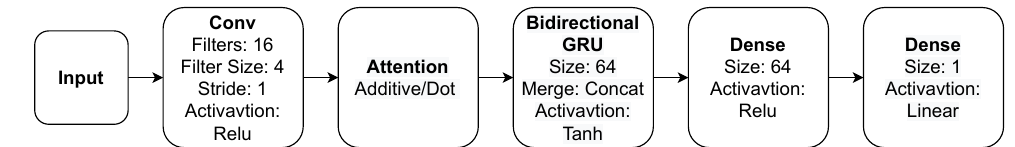
Figure 4. Architecture of